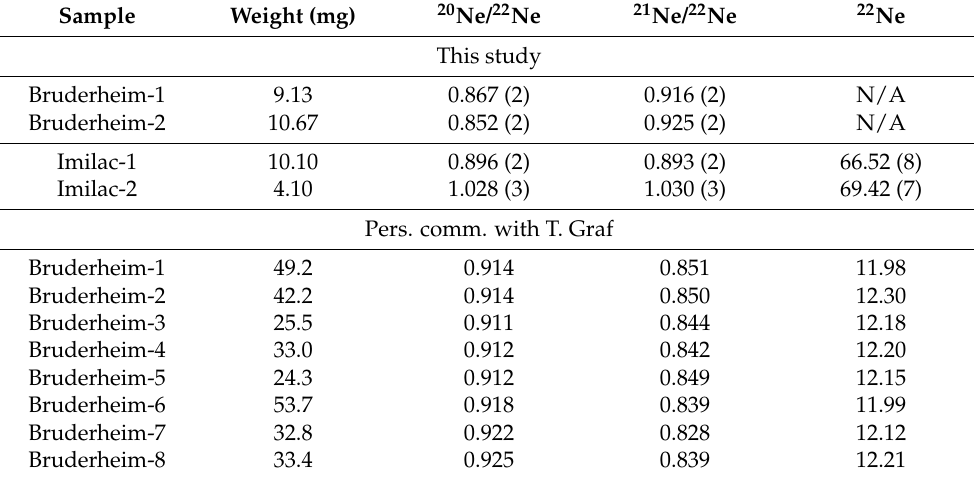
Table 1. Neon isotope data of newly measured